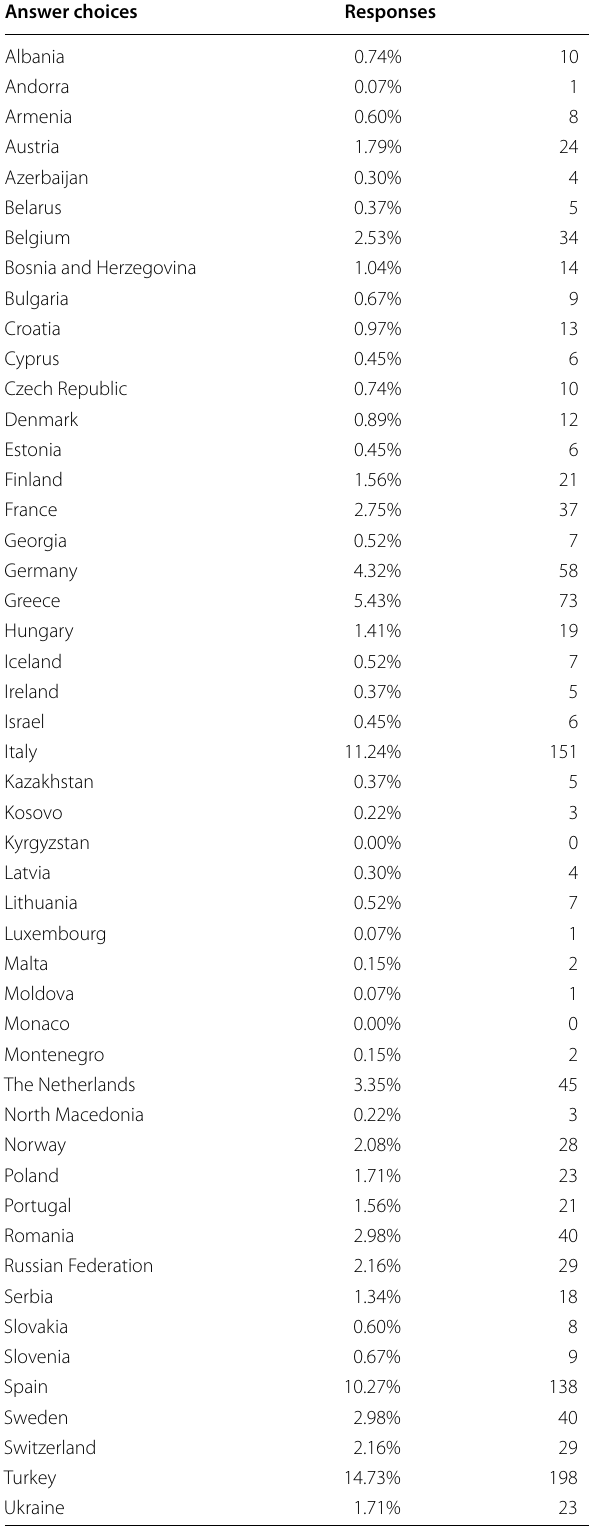
Table 1 In which country do you practice?